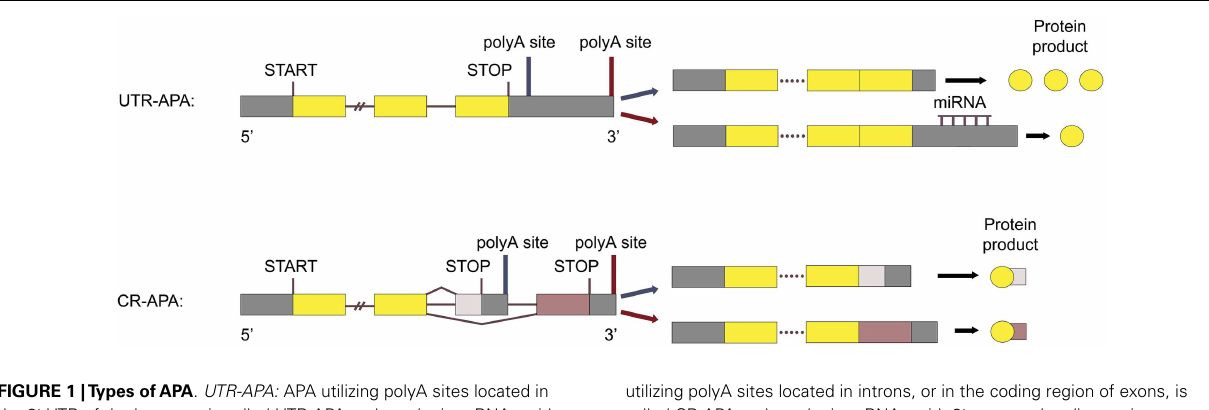
utilizing polyA sites located in introns, or in the coding region of exons, is called CR-APA and results in mRNAs with 3 (cid:48) truncated coding regions. Adapted from Ref.